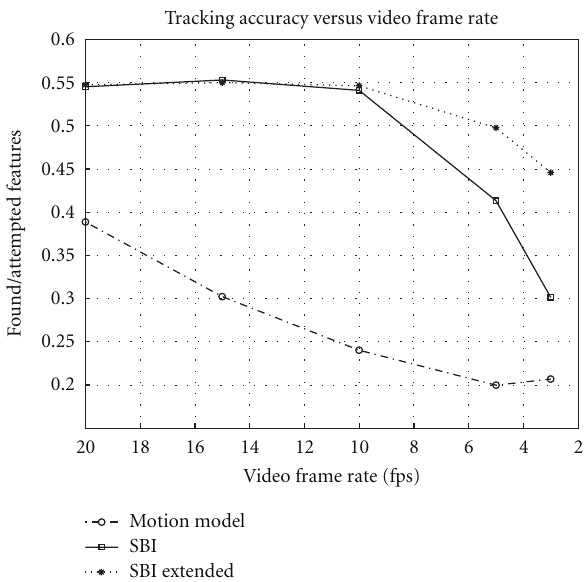
Figure 6: Comparison of the tracking quality for a real image se- quence played at di ff erent frame rates.